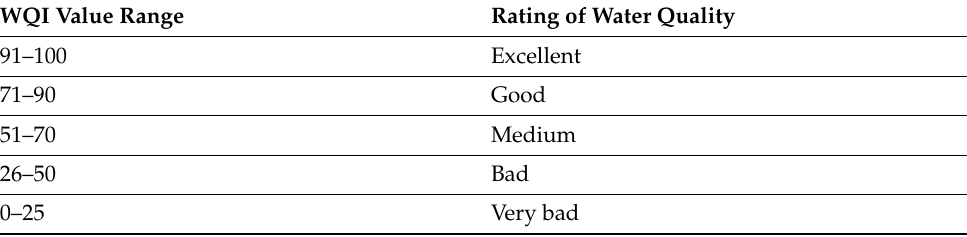
Table 5. Water quality rating according to National Sanitation Foundation Water Quality Index methods.